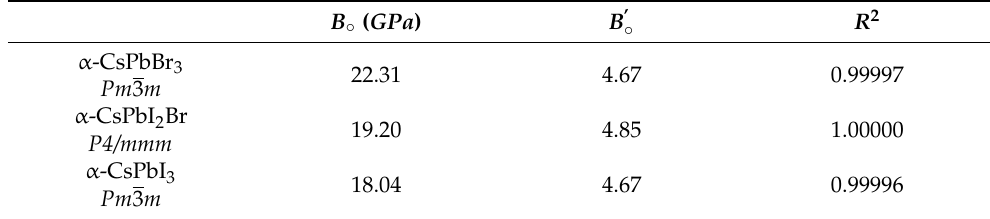
Table 2. Fitted zero- ( B ◦ ) and first-order ( B (cid:48) ◦ , dimensionless) portions of the bulk modulus ( B ) from the energy vs. volume response curve fit to the Birch–Murnaghan equation of